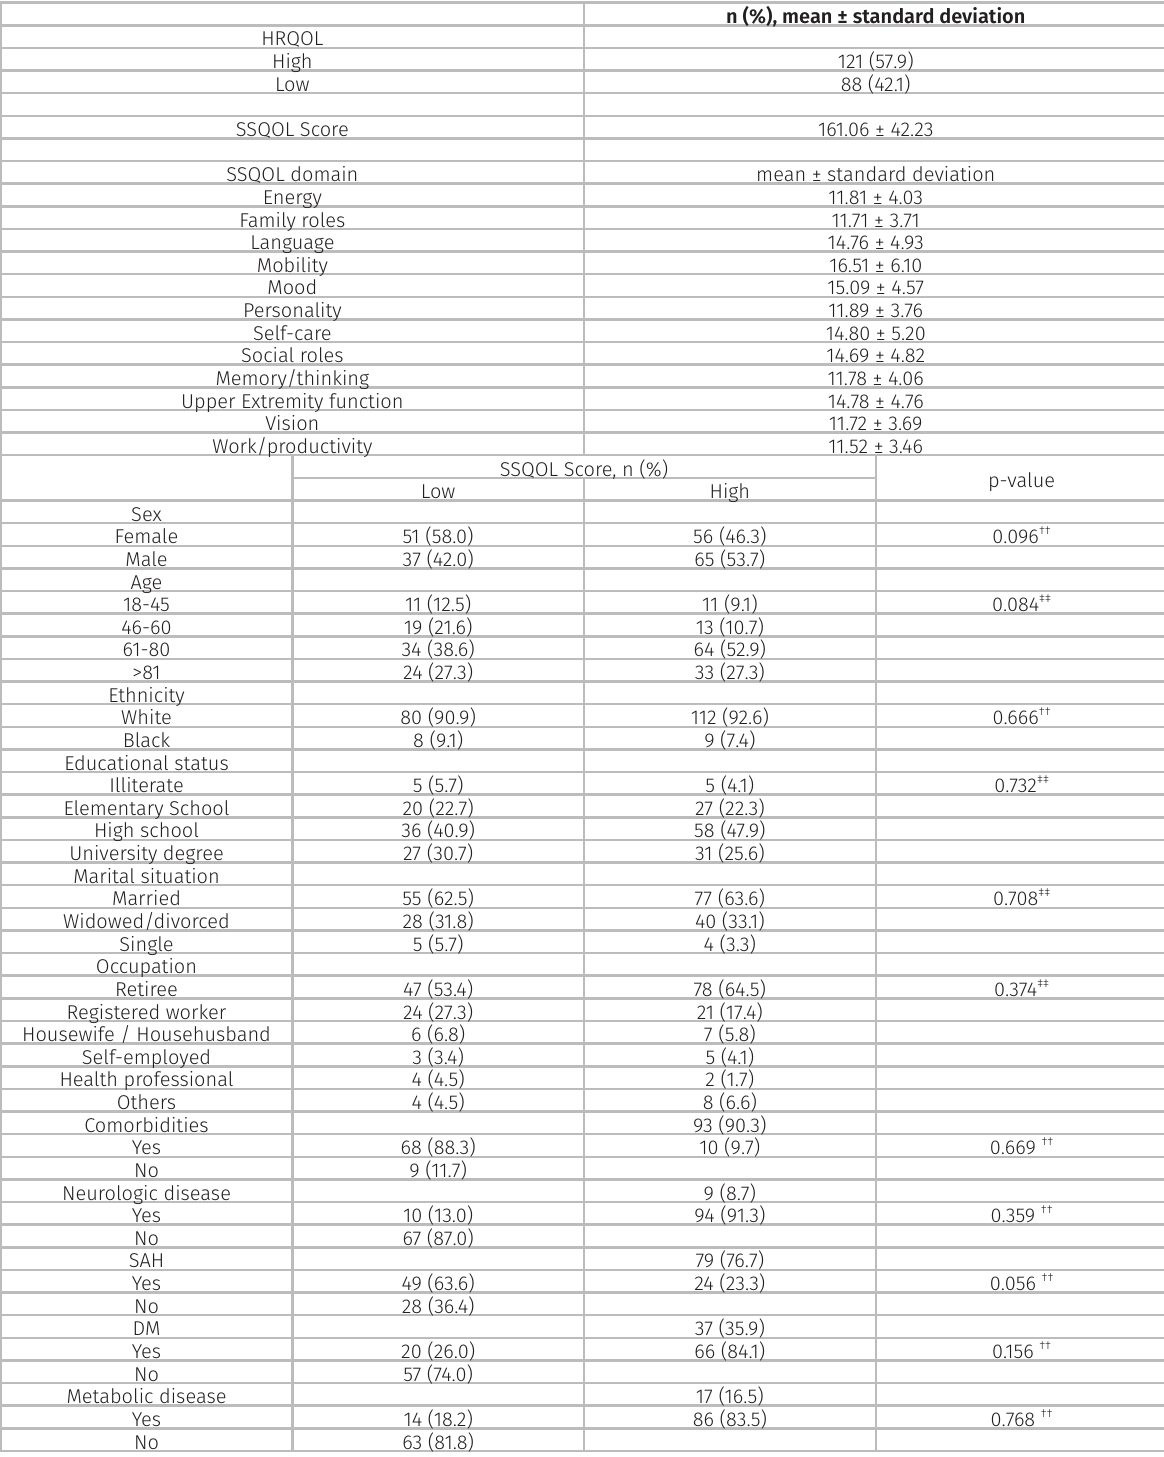
Table V. Quality of life characteristics in adult population with stroke diagnosis in a private hospital in southern